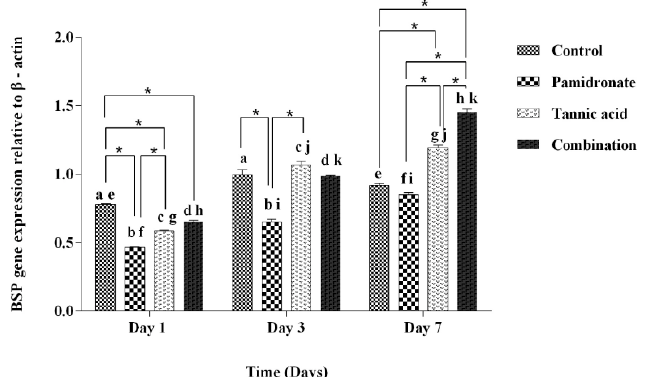
Figure 5. The gene expression of BSP relative to β -actin at Days 1, 3, and 7 in hFOB 1.19 cells ex- pressed by control (DMSO treated), pamidronate (PAM), tannic acid (TA), and combination treatment (TA + PAM) groups analyzed by PCR. All data are shown as the mean (SEM) of three independent experiments. Days that share a similar letter display a significant difference within the same group ( p < 0.05), whereas * shows a significant difference among the four groups in similar day ( p < 0.05) by one-way ANOVA and Tukey’s